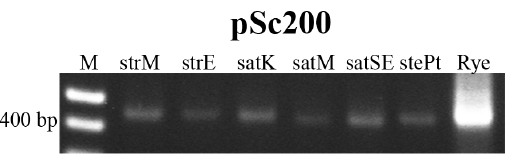
Figure 3. PCR amplification products obtained using pSc200 primers. M: molecular marker 1 Kb+; strM— A. strigosa from Madeira Island; strE— A. strigosa from Elvas; satK— A. sativa “Kyto”; satM— A. sativa from Madeira Island; satSE— A. sativa “S. Eulália”; stePt— A. sterilis Pt; Rye— S. cereale .